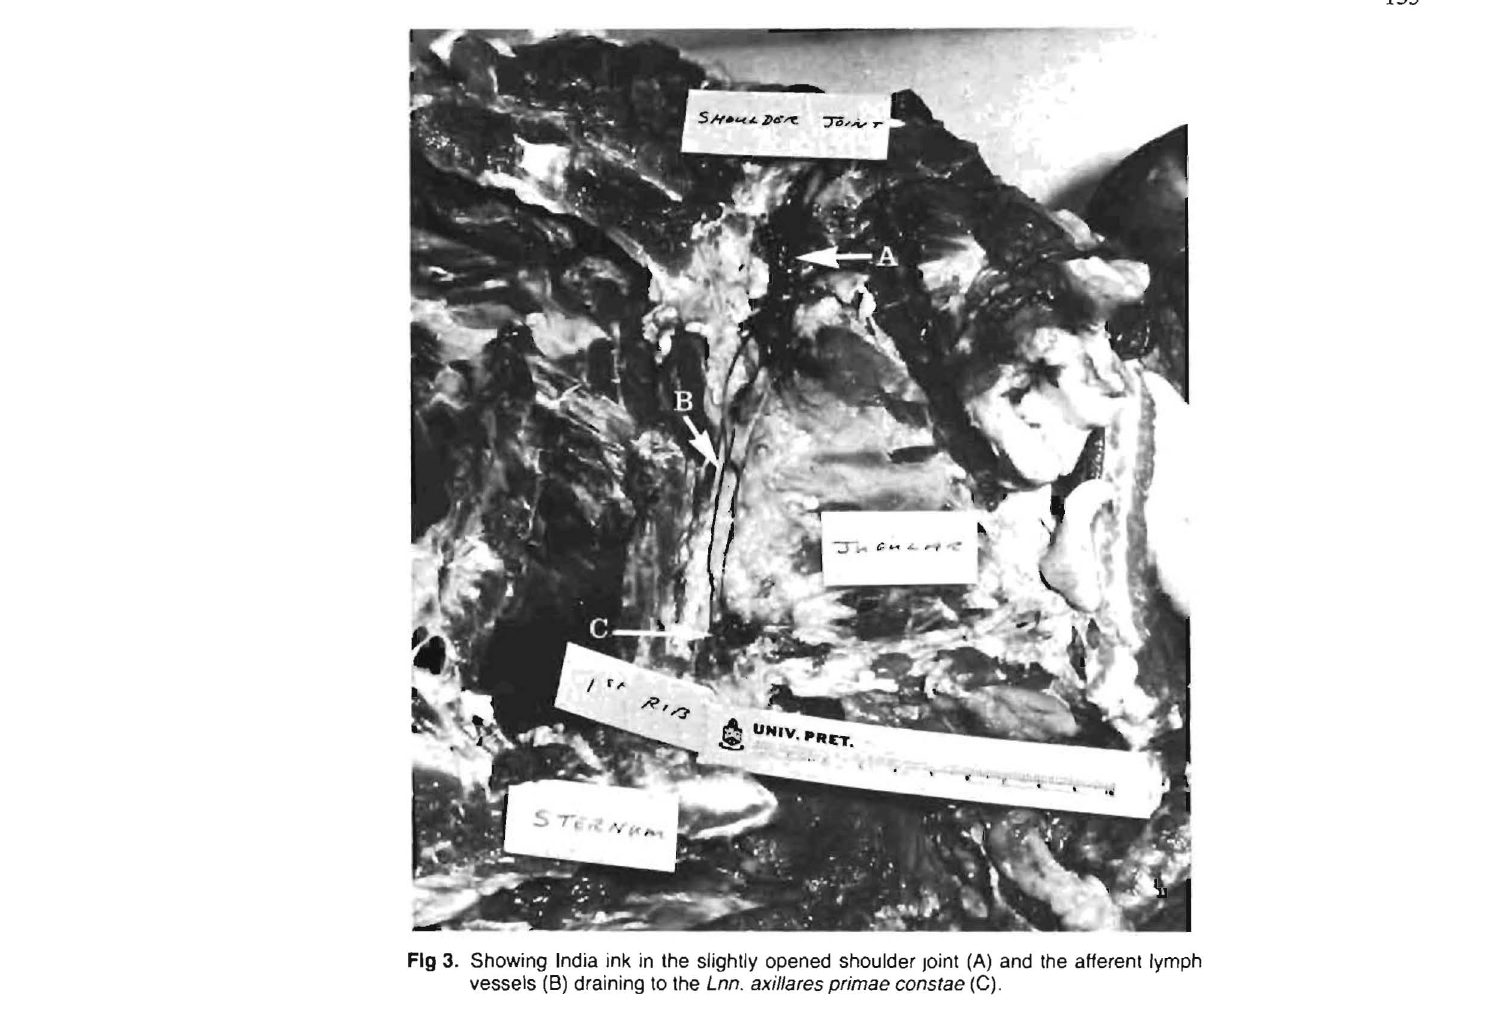
Fig 3. Showing India ink in the slightly opened shoulder Joint (A) and the afferent lymph vessels (8) draining to the Lnn. axil/ares primae cons/ae